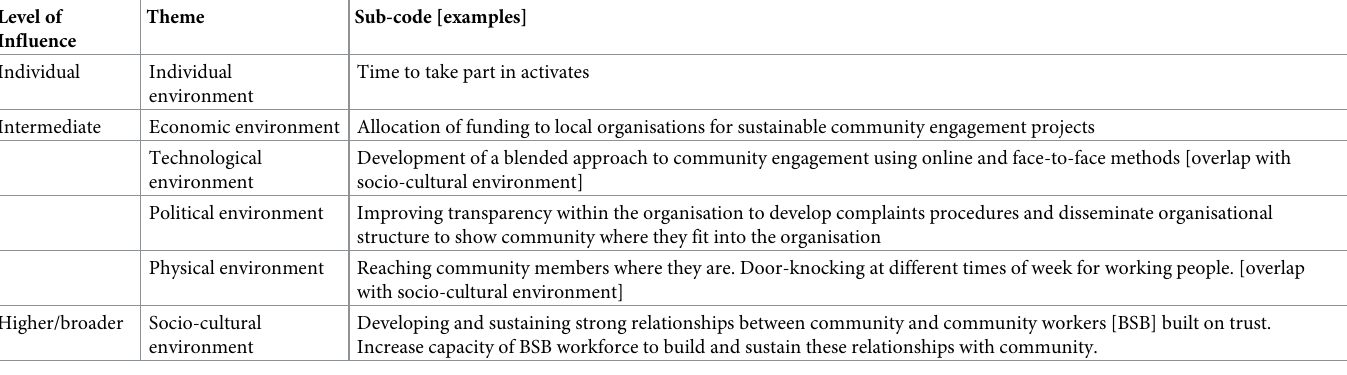
Table 1. Levels of themes from the